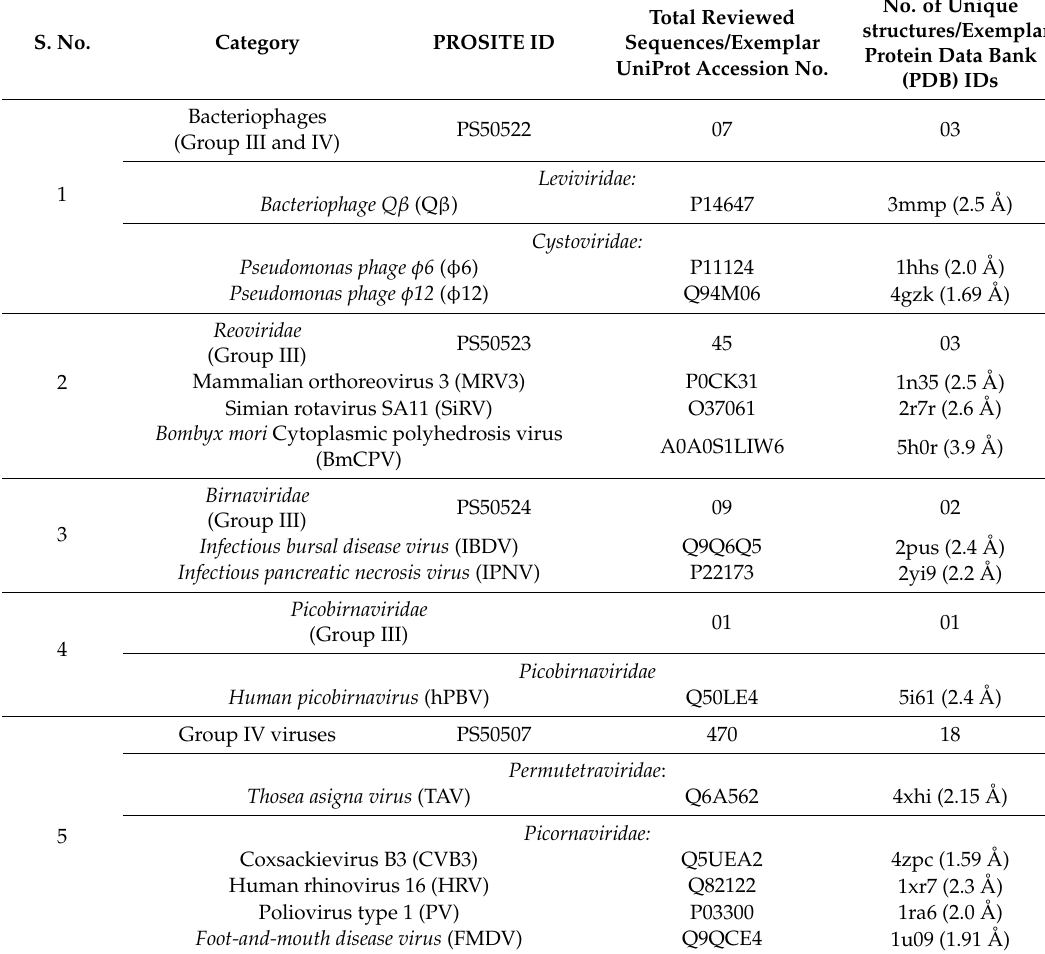
Table 1. Classification of RNA dependent RNA polymerases (RdRps) of different RNA viruses based on PROSITE accession no. PRU00539